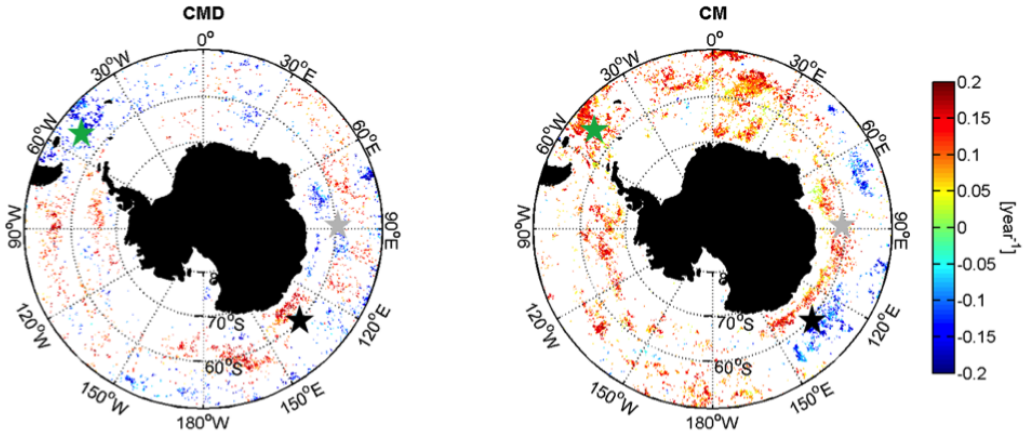
Figure 7. Trends of the annual standardized anomalies of date of Dia-Chla maximum (CMD) and Dia-Chla maximum (CM). Reddish colour indicates a positive trend and bluish indicates a negative trend. Only statistically significant trends ( p < 0.05) are shown. The stars highlight the regions between Malvinas and South Georgia Islands (green) and south of 60 ◦ S between 120 ◦ E to 150 ◦ E (black) and 60 ◦ E to 120 ◦ E